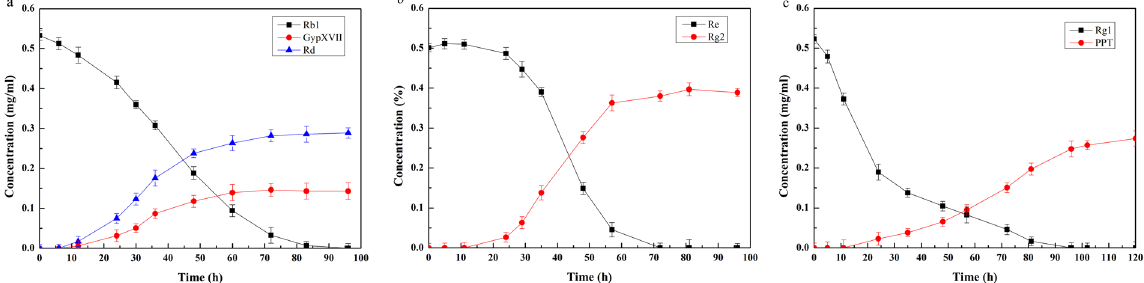
Figure 3. Time courses of ginsenoside Rb1 ( a ), Re ( b ), and Rg1 ( c ) during biotransformation process by using Cellulosimicrobium sp.